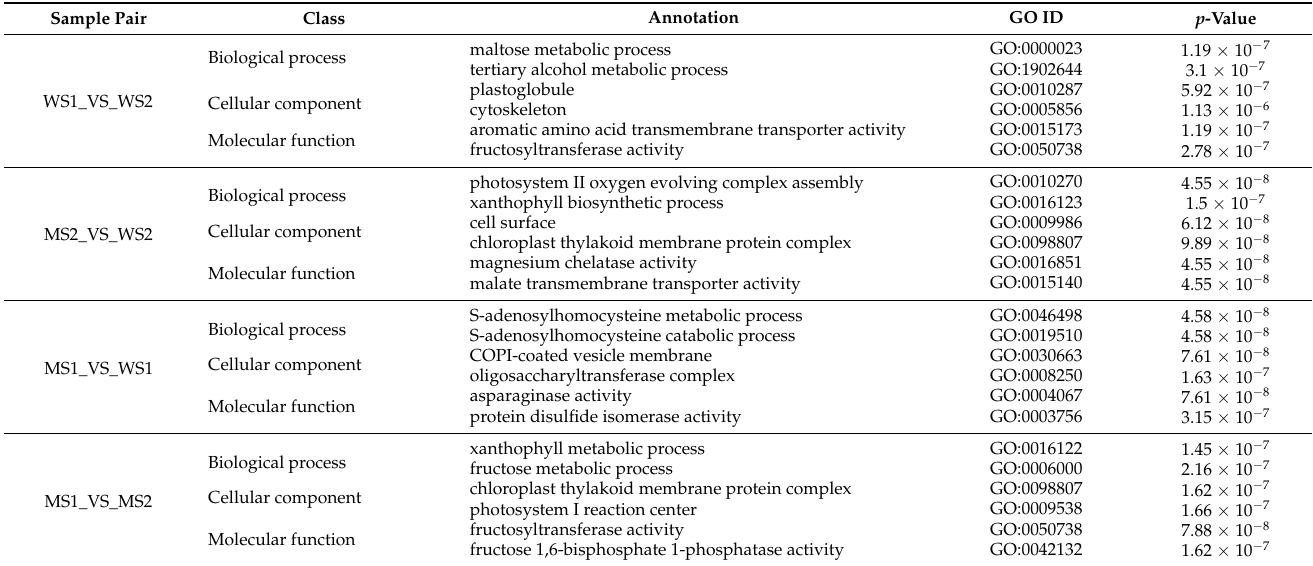
Table 4. main enrichment pathways of DEG in 4 groups, refer to go database.